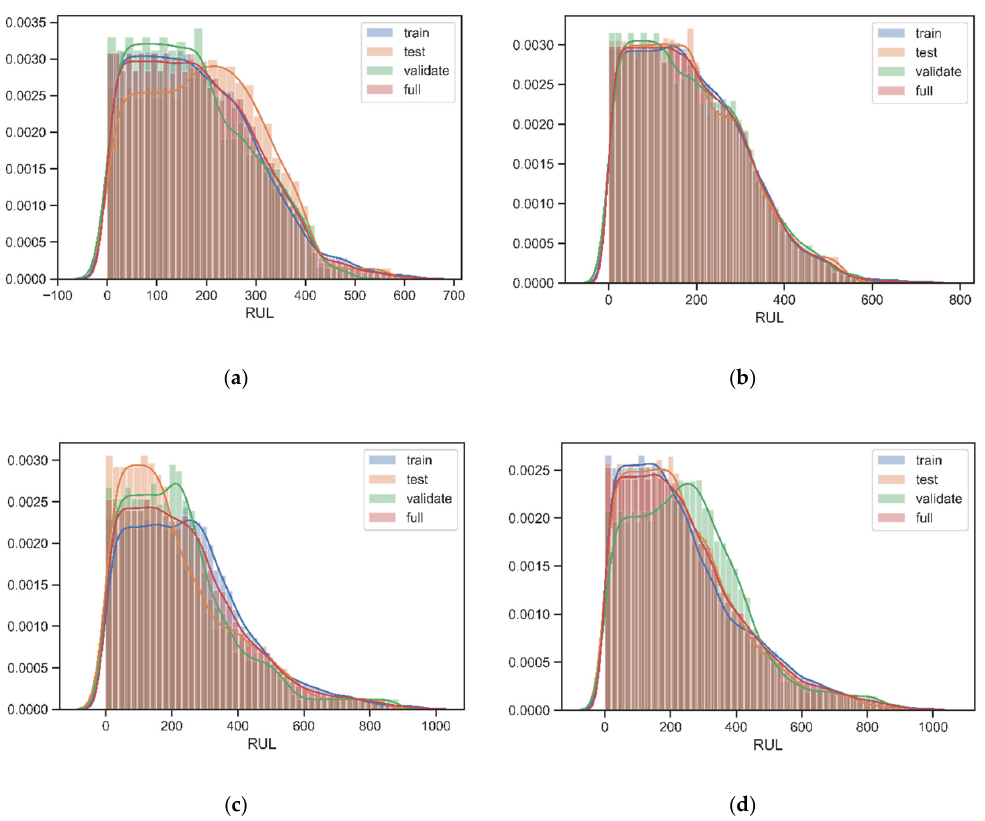
Figure 18. Comprehensive comparison of prediction RUL of AM-FGRNET. ( a – d ) Represent the FD001–FD004 datasets, respectively.